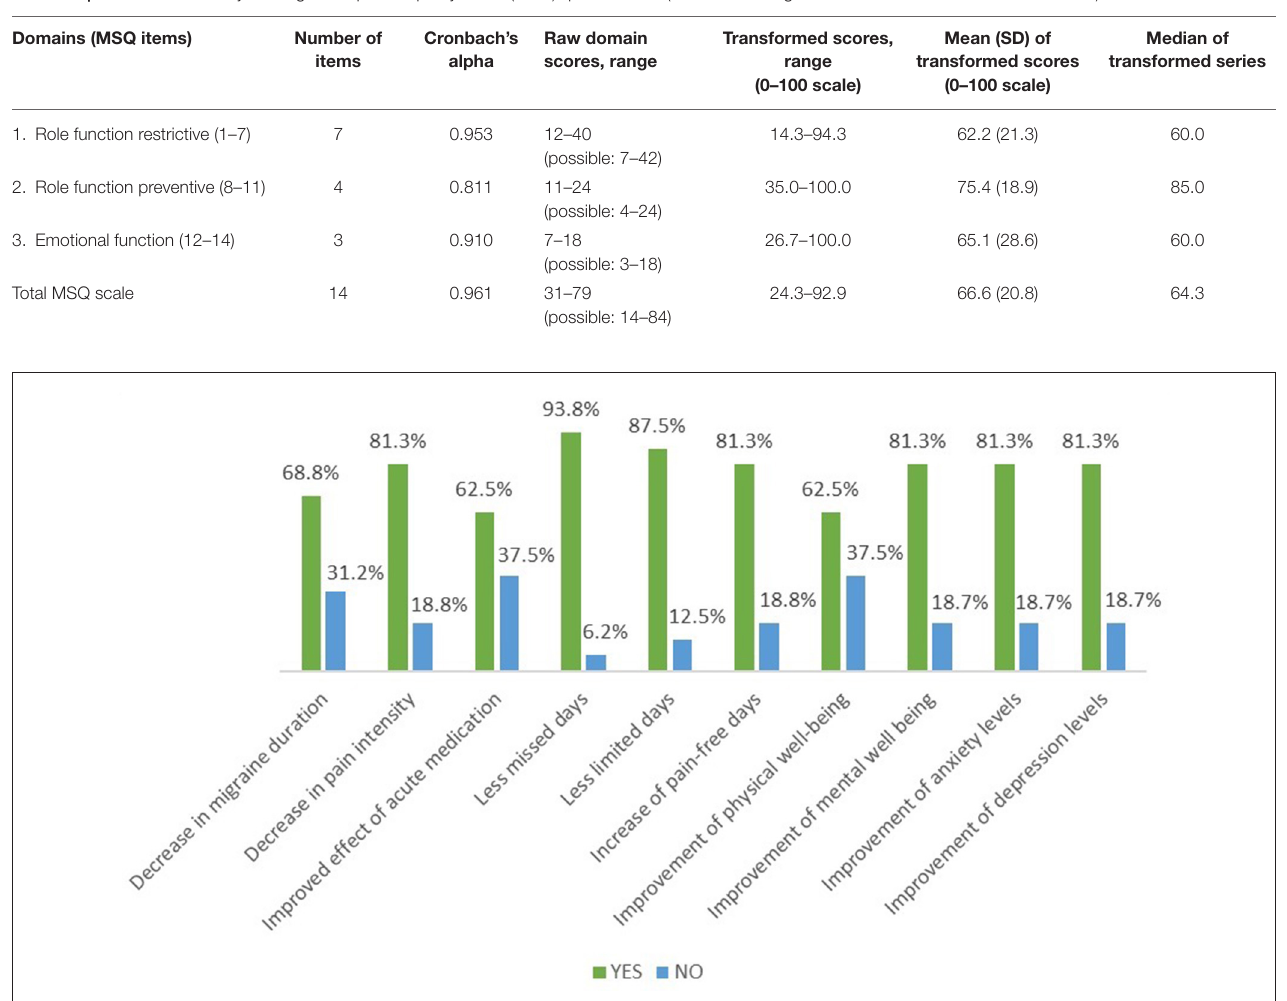
FIGURE 1 | Three-month interval subjective assessment of erenumab therapy. The vast majority of the patients reported an improvement of all the parameters